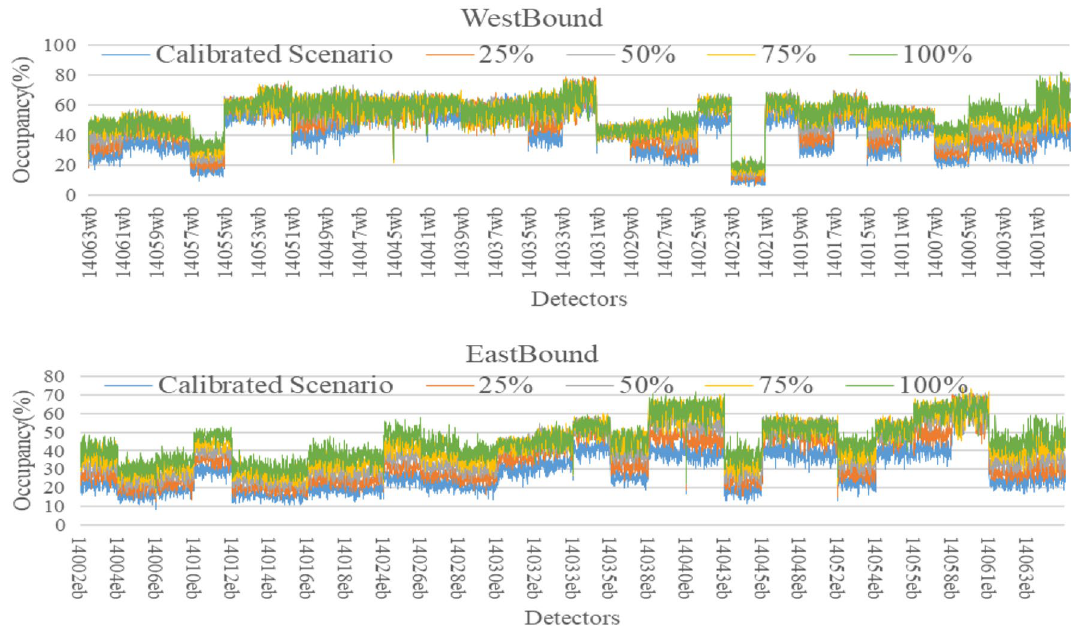
Figure 12. Future occupancy data generated from